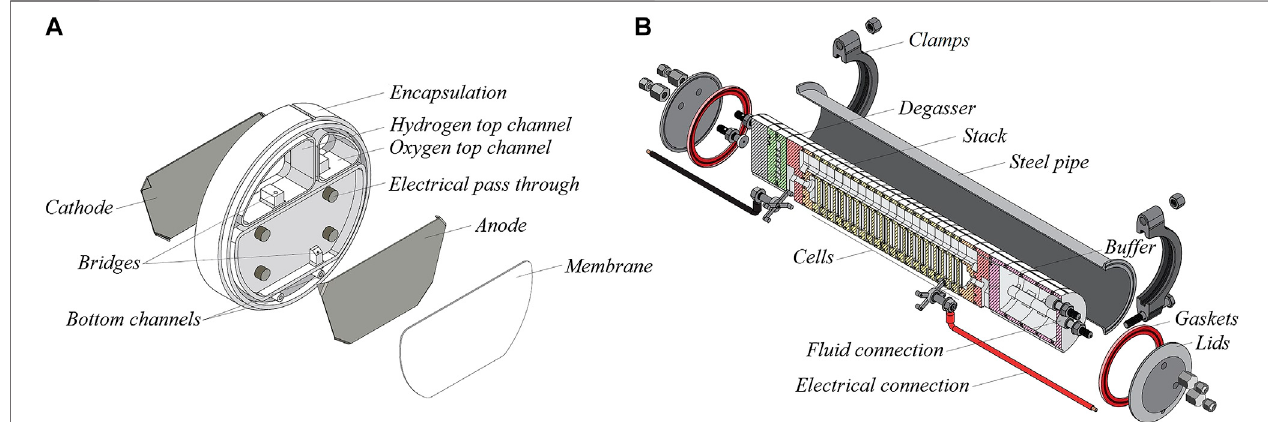
FIGURE 1 | (A) Exploded view of mini-cell for bipolar zero gap alkaline electrolysis. Apart from the electrodes and the Zirfon-Perl membrane, it will be made of an injectionmouldedpolymerthatwillwithstandtheharshconditionsof50 barO 2 and30 wt%KOHatatemperatureof90 ° C.Thepolymerencapsulationfunctionsnotonly as housing, but also contains two compartments, where the H 2 and O 2 gases are collected (courtesy ZEF, Netherlands). (B) Module of 18 photo-voltaic powered mini- cells, which embody a solar powered mini-plant for H 2 production (courtesy, ZEF, Netherlands). It will be integrated with a methanol synthesis reactor. The 50 bar pressureinthemini-cellseliminatestheneedofacompressor.Thismakesthesystemmoreef fi cient.Theoverallef fi ciencyisraisedfurtherbytheelevatedtemperatureof 90 ° C in the